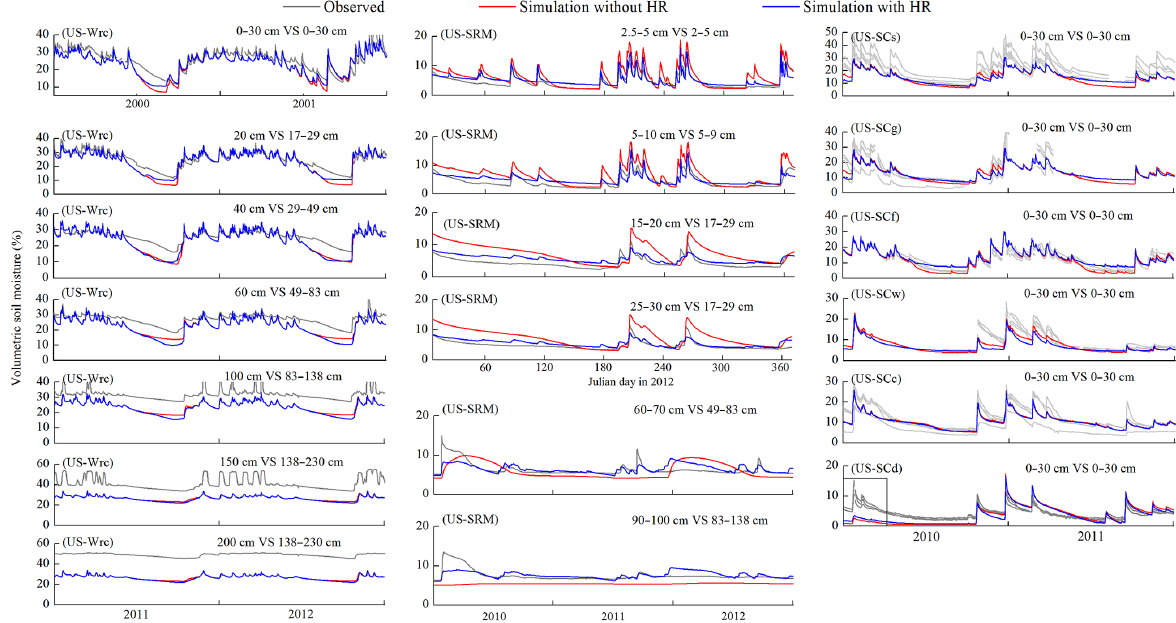
Figure 1. Observed and simulated soil moisture over selected years. Labels at the upper right corner of each soil moisture panel show the depths of observed and simulated soil moisture. For example, “20cm VS 17–29cm” means the observation depth of soil moisture is 20cm and the simulated results at depths of 17–29cm were compared with this observation. Within panels for southern California sites (US-SCs, US-SCg, US-SCf, US-SCw, US-SCc, and US-SCd), the four grey lines are data from the four CS-616 soil moisture sensors at 0–30cm depth. Results were shown for the last year only (2012) for the top 30cm depths at US-SRM site for clarity. The rectangular box indicated period with incomplete precipitation record.